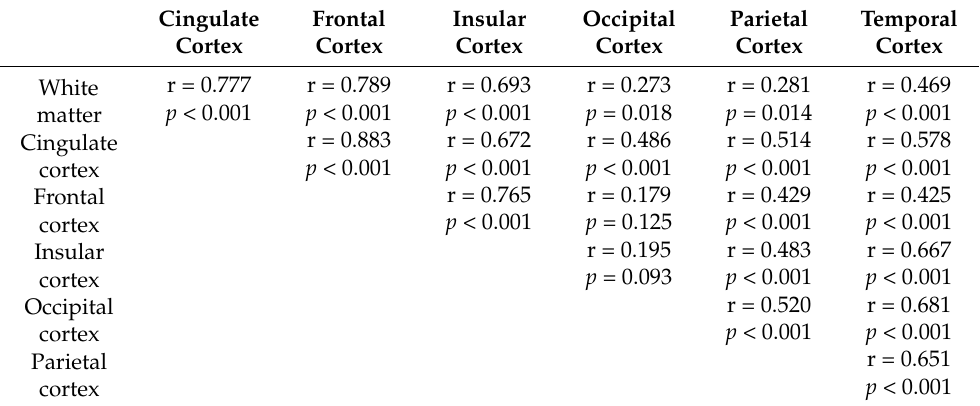
Table 2. Relation of BBB permeability between white matter and cerebral regional